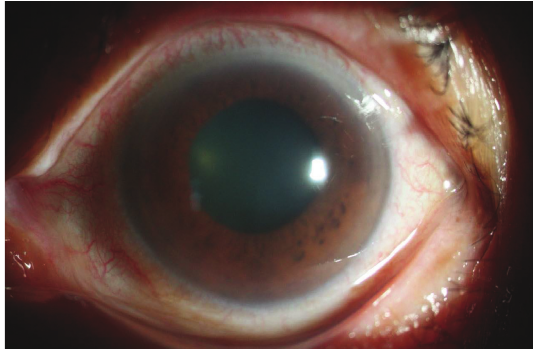
Figure 2: Preoperative image of a patient with acute angle closure. The preoperative treatment included pilocarpine, topical anti- glaucoma drops, oral carbonic anhydrase inhibitors, and mannitol.